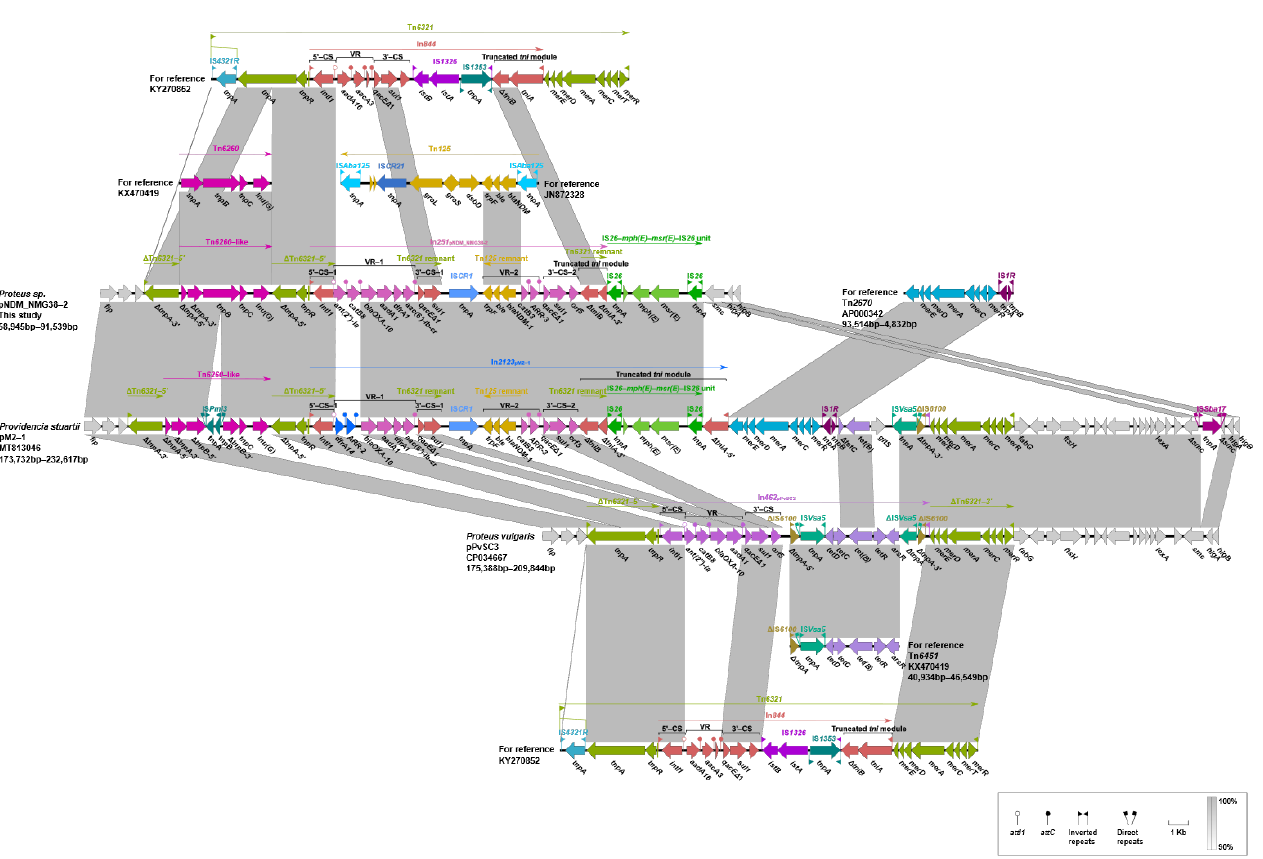
Figure 5. Organization of the MDR-2 of pPvSC3-like plasmids and comparison to related regions. Genes are denoted by arrows. Genes, mobile elements, and other features are colored based on their functional classification. Gray shading denotes regions of shared homology ranging from 90% to 100%. Δ represents truncated genes or mobile genetic elements.